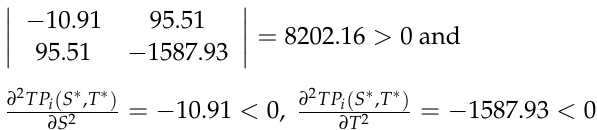
Figure 5. Comparison chart of current model with [28]. From Figure 5, it is observed that the retailer will generate more profit if the retailer receives the credit period from the supplier. In addition, the various situations indicate that as the credit period increases, the total profit of the retailer also increases. Therefore, if the retailer receives a higher credit period from the supplier, then the retailer generates the maximum revenue. As a result, the inclusion of a trade credit policy benefits both the supplier and retailer by increasing the demand for goods and generating revenue by earn ‐ ing some interest.